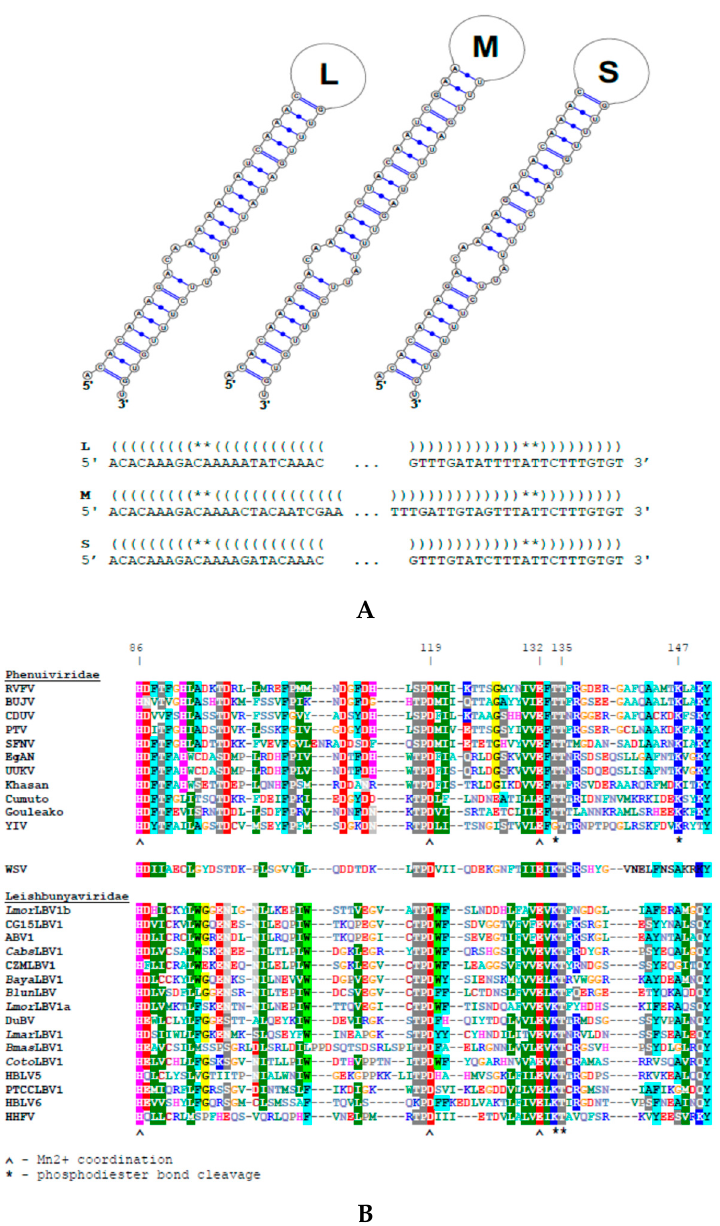
Figure 2. Structural features of Lmar LBV1. ( A ) Secondary structures and complementary sequences on 5 ′ and 3 ′ ends of the Lmar LBV1 L, M, and S RNA segments predicted by IPknot. (and) depicting complementary nucleotides forming the stem, *-non-complementary nucleotides forming a bulge. ( B ) Amino acid alignment of the N-terminal endonuclease domain of RDRP of Leishbunyaviridae and Phenuiviridae . Functionally important residues are marked with arrowheads. Numbering of positions in alignment are indicated as in Lmar LBV1 polymerase protein. Shading: ≥ 80% identity within Phenui and Leishbunyaviruses + Wuhan Spider virus (LBV+WSV).